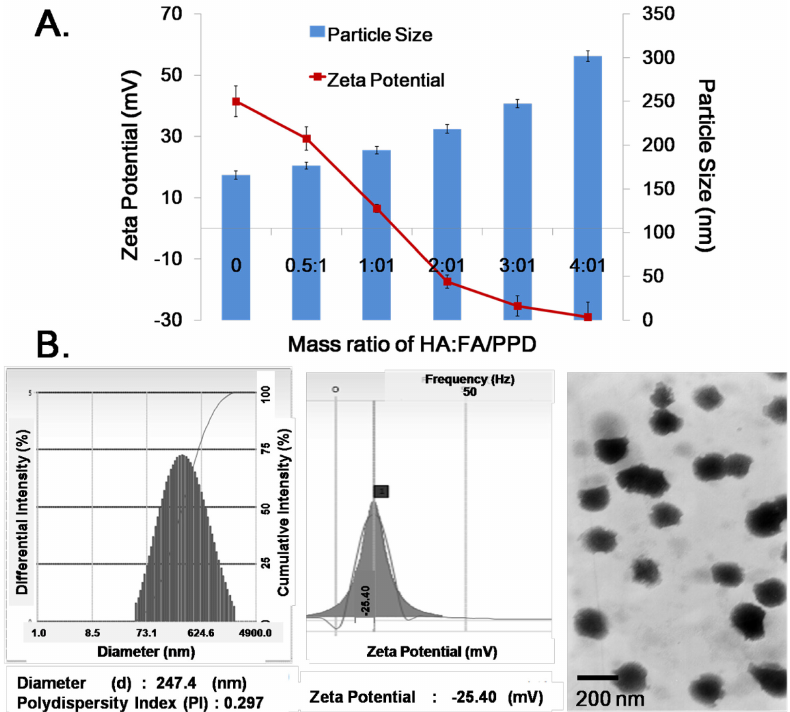
Figure 3. Formation and characterization of HA/FA/PPD ( n = 3). ( A ) Particle size and zeta potential of liposomes with different mass ratio of HA and FA/PPD; ( B ) Particle size, zeta potential and TEM morphology of finally obtained